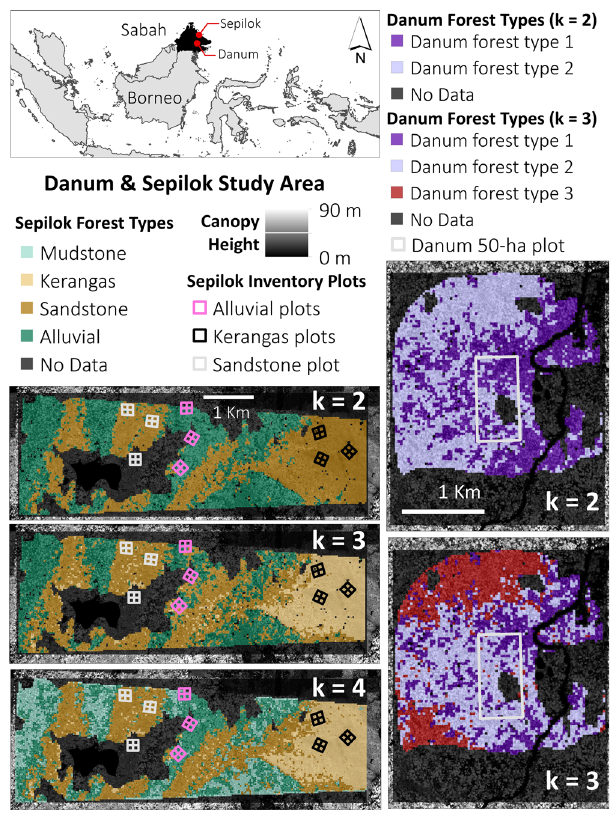
Fig. 1 Mapped forest types. Mapped forest type results from PCA and k - means clustering of 10 variables across forest ecosystems in Sepilok Forest Reserve for k = 2, 3, and 4, and in Danum Valley Conservation Area around the 50 ha Smithsonian ForestGEO plot for k = 2 and 3. Here, we omit the Danum k = 1 map, which would show a single color for the entire area, and instead highlight the difference between k = 2 and k = 3 cluster results. At Sepilok, the partitioning of the alluvial forest into alluvial and mudstone forest types is revealed with k = 4. The canopy height shading scale indicates the top-of-canopy height information from the airborne LiDAR. Black areas in the clustered forest type maps indicate No Data where pixels were omitted, or cloud, cloud shadow, and water